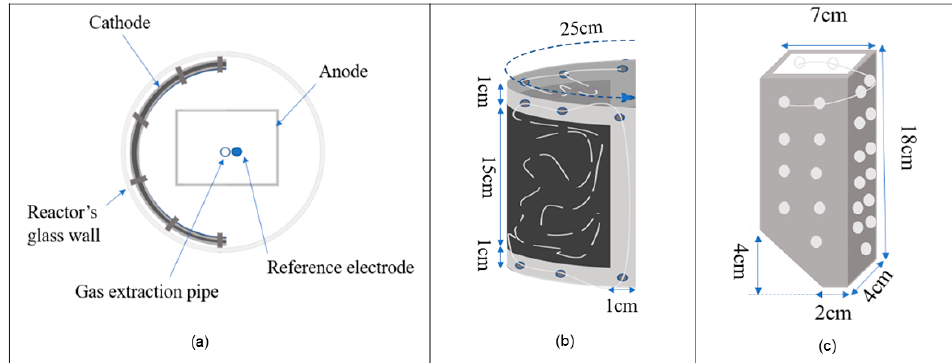
Figure 5. An upper cross-section of the reactor with electrode arrangements and electrode design with dimensions. ( a ) The upper cross-section, ( b ) the cathode, and ( c ) the anode.